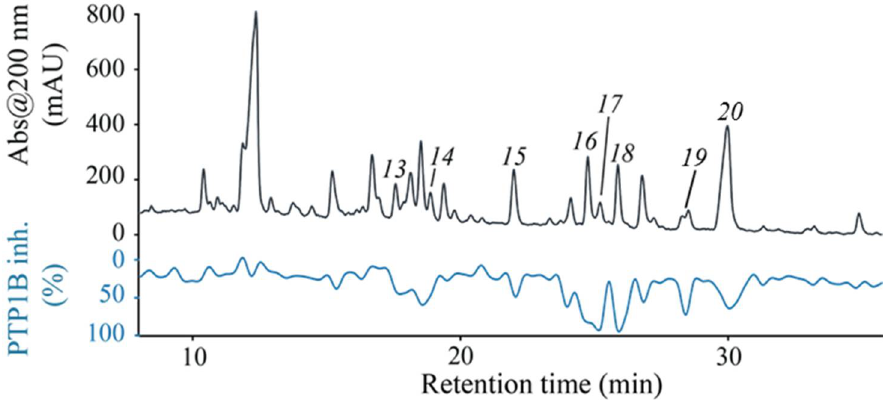
Figure 3. High-resolution PTP1B inhibition profiling of fraction F1 . Black trace: UV absorption at 200 nm; Green trace: PTP1B inhibition profiling.